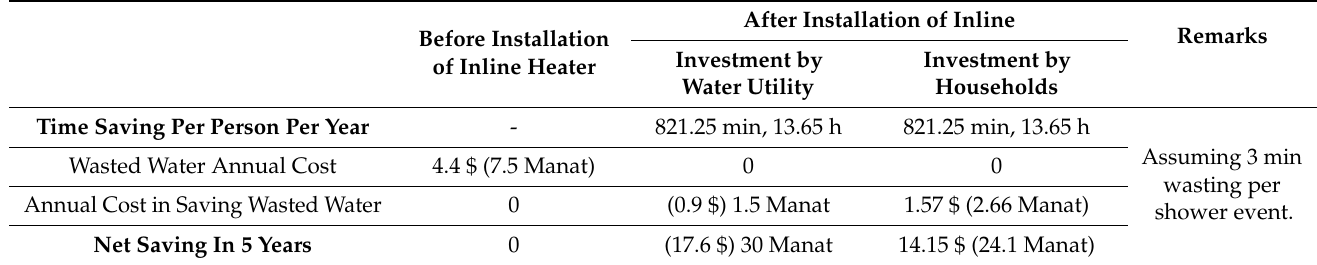
Table 7. Techno-economy analysis for “Direct